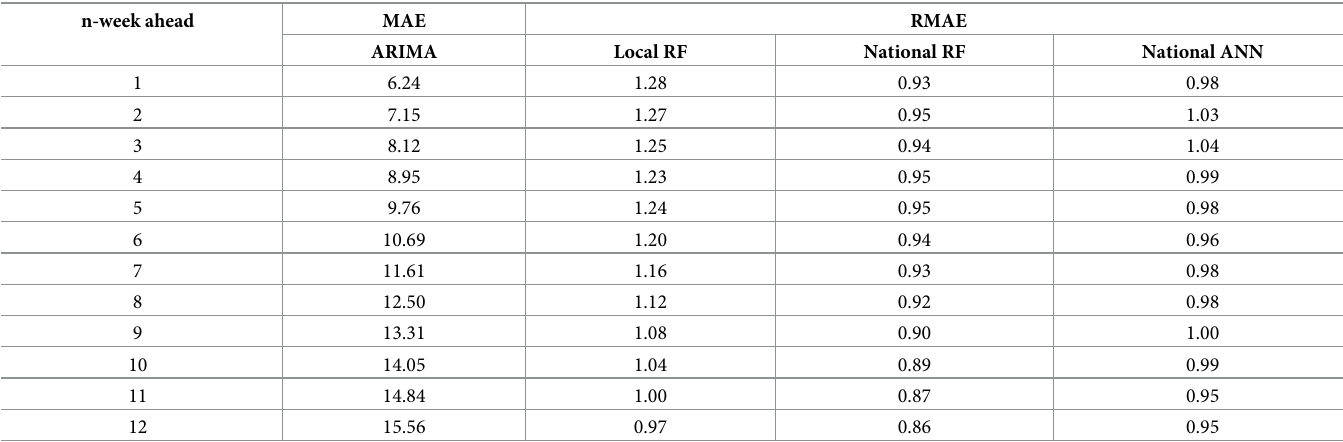
Table 3. Accuracy comparison among ARIMA, RF, and ANN model for prediction of 2018.